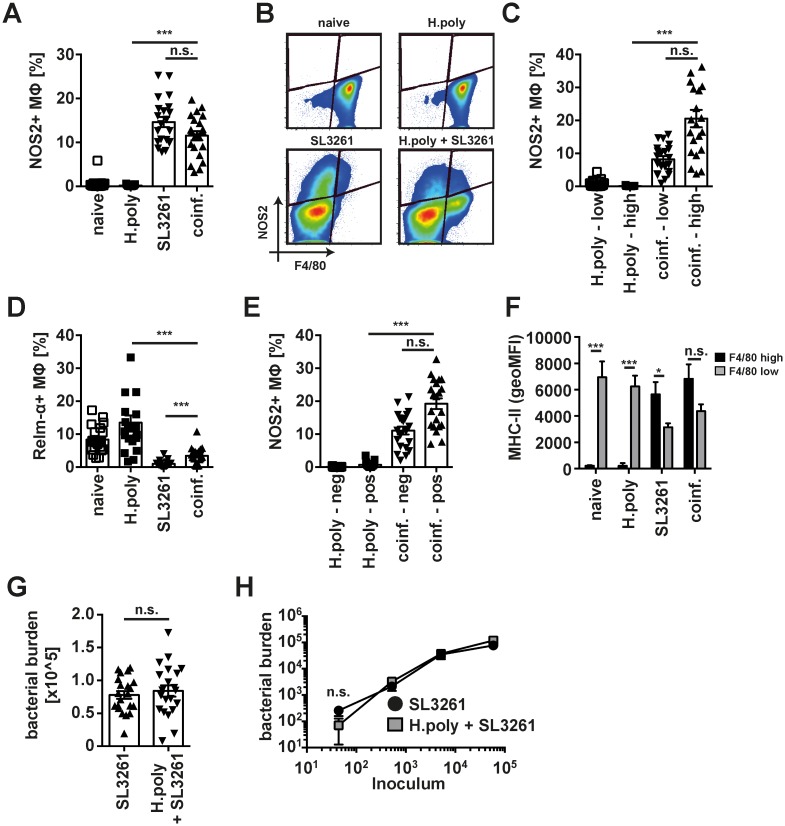
Helminth-expanded MΦ upregulate NOS2 and MHC-II expression following bacterial infection.(A) Intracellular NOS2 staining in peritoneal MΦ from SL3261 (SL3261), H. polygyrus (H.poly) co-infected (coinf.) or naive mice. (B) Representative dot plots depicting NOS2 vs. F4/80 expression in peritoneal MΦ isolated in A. (C) Quantitative analysis of NOS2 expression in F4/80high (high) or F4/80low (low) MΦ isolated in A (D) Intracellular Relm-α staining in MΦ isolated in A. (E) Quantitative analysis of NOS2 expression in Relm-α positive (pos) or negative (neg) MΦ isolated in A (F) MHC-II expression (geometric mean fluorescence intensity) on F4/80high and F4/80low MΦ isolated in A. (G) Splenic bacterial burden in single SL3261 (SL3261) or consecutively H. polygyrus./ SL3261 co-infected (H.poly + SL3261) mice. Data pooled from 4 separate experiments with 5–6 animals per group per experiment. Datapoints depict individual animals and bars indicate mean and SEM. (H) As in G utilizing indicated infection doses of SL3261. One representative experiment of 2 with 5 animals per group shown. *: p<0.05; **: p<0.01, ***; p<0.001; n.s.: not significant.